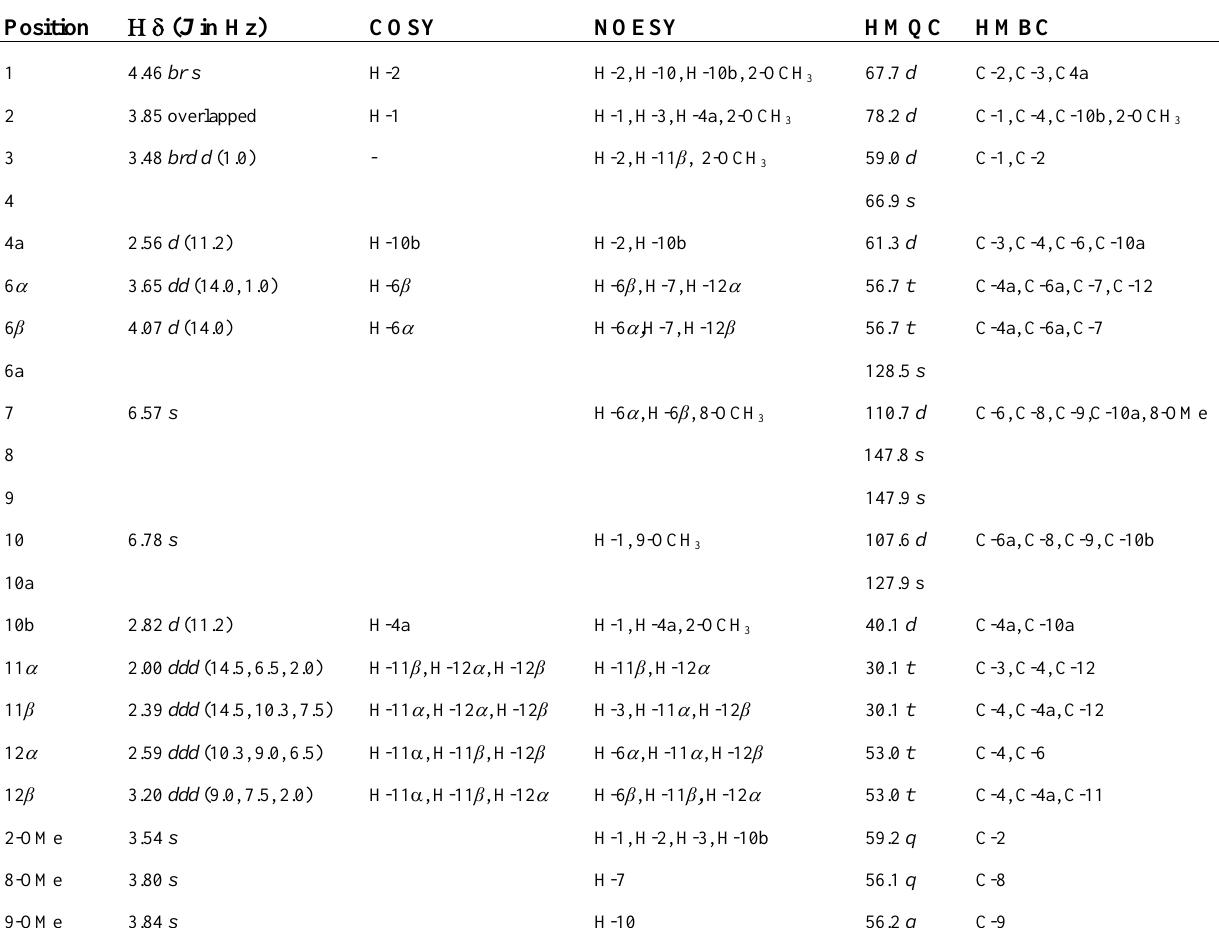
Table 1. 1 H-NMR, COSY, NOESY and 13 C-NMR data for 1